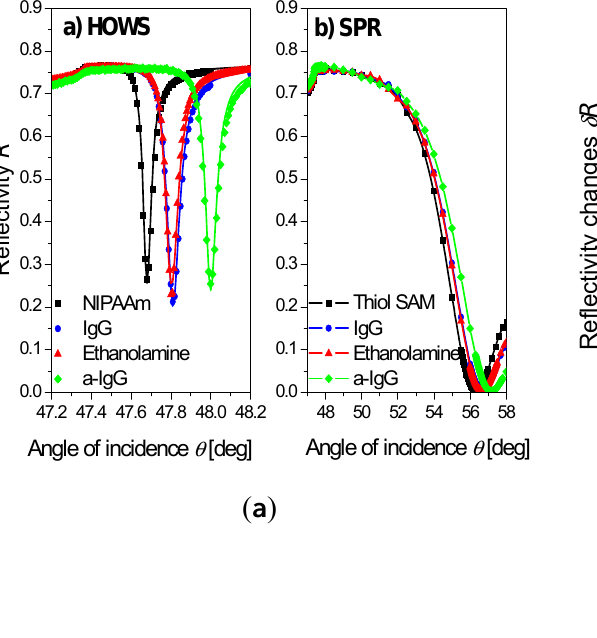
Figure 9. ( a ) Reflectivity spectra measured by hydrogel optical waveguide spectroscopy (HOWS) in an approximately 2 μ m thick hydrogel binding matrix, compared with those for regular SPR with thiol SAM surface architecture. The spectra of the pristine hydrogel (squares), after immobilization of IgG capture antibodies (circles), passivation with ethanolamine (triangles), and affinity capture of the a-IgG target analyte (diamonds) are shown. ( b ) Calibration curve obtained by HOWS and SPR for a model immunoassay experiment. (Reproduced with permission from